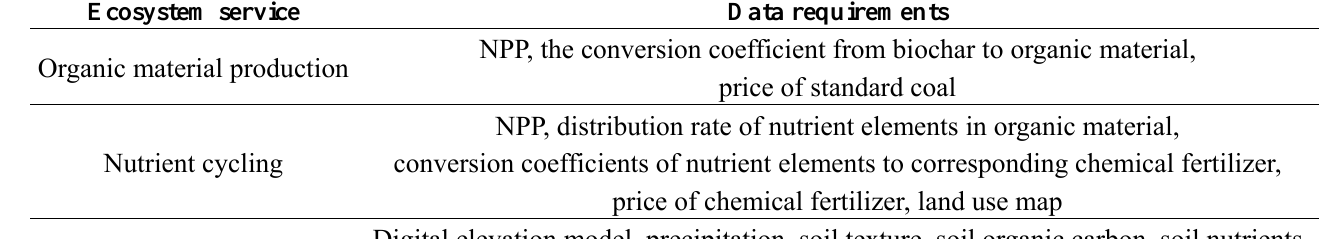
Table 1. Parameters and data requirement of the NPP based ecosystem service model. Ecosystem